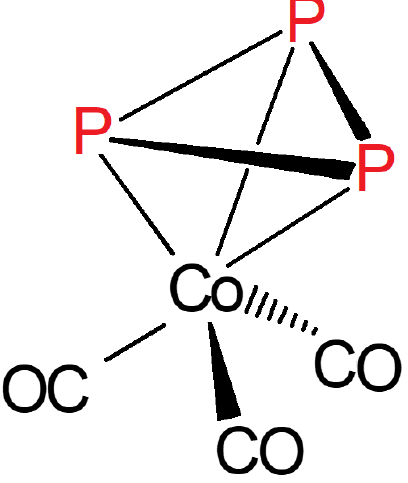
Figure 5. Schematic view of the structure of complex 7 [33]. Catalysts 2018 , 8 , x FOR PEER REVIEW